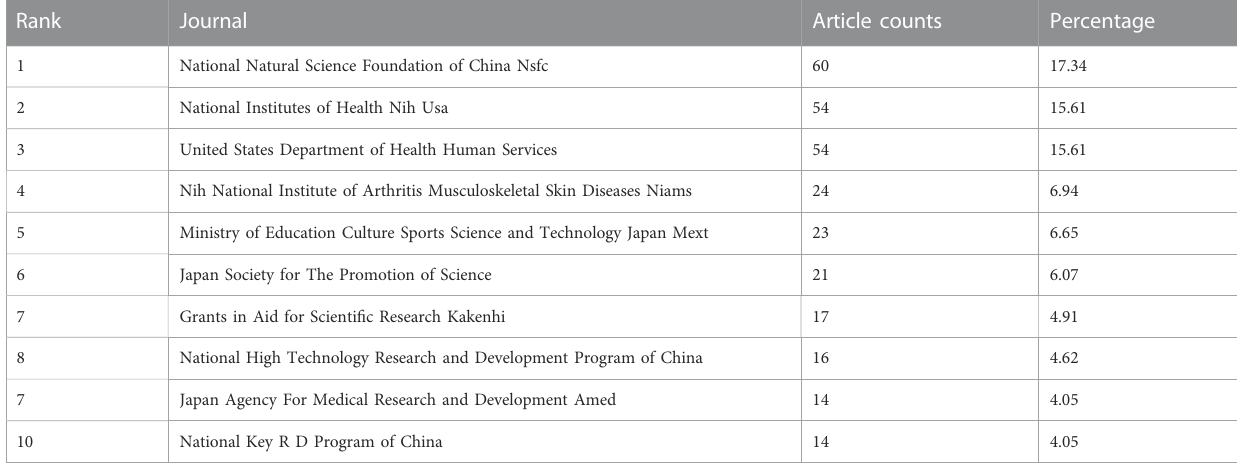
TABLE 8 The top 10 funds related to stem cells for meniscal